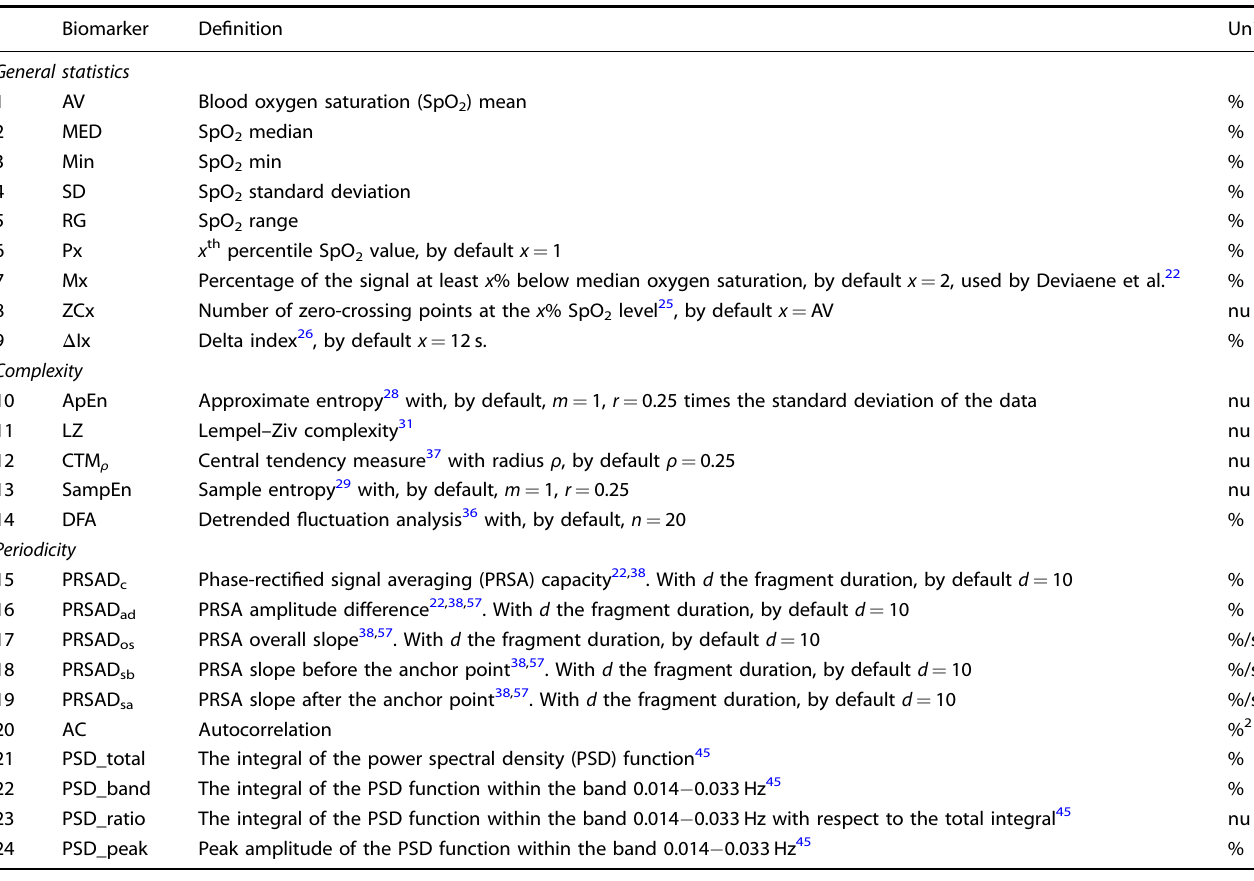
Table 3. List of digital oximetry biomarkers for the categories: general statistics, complexity, and periodicity.